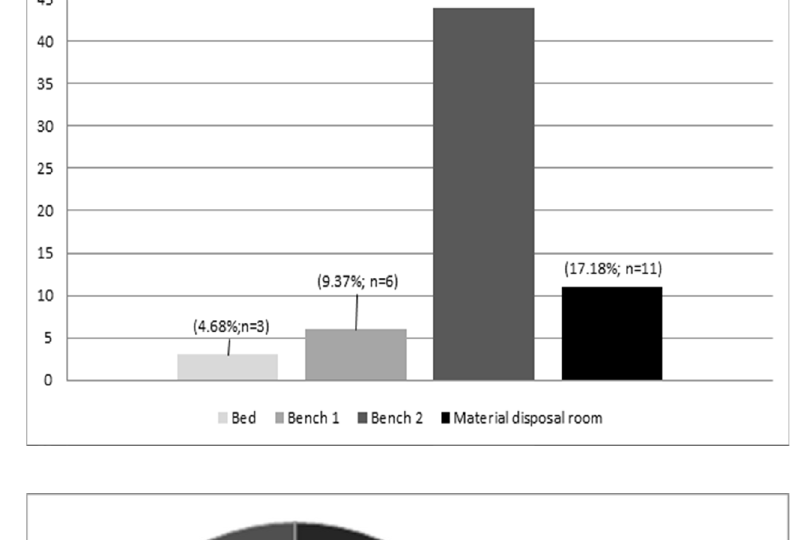
Figure 2. Candida spp. on hospital ICU environment surfaces of the hospital located in the in the city of Pelotas